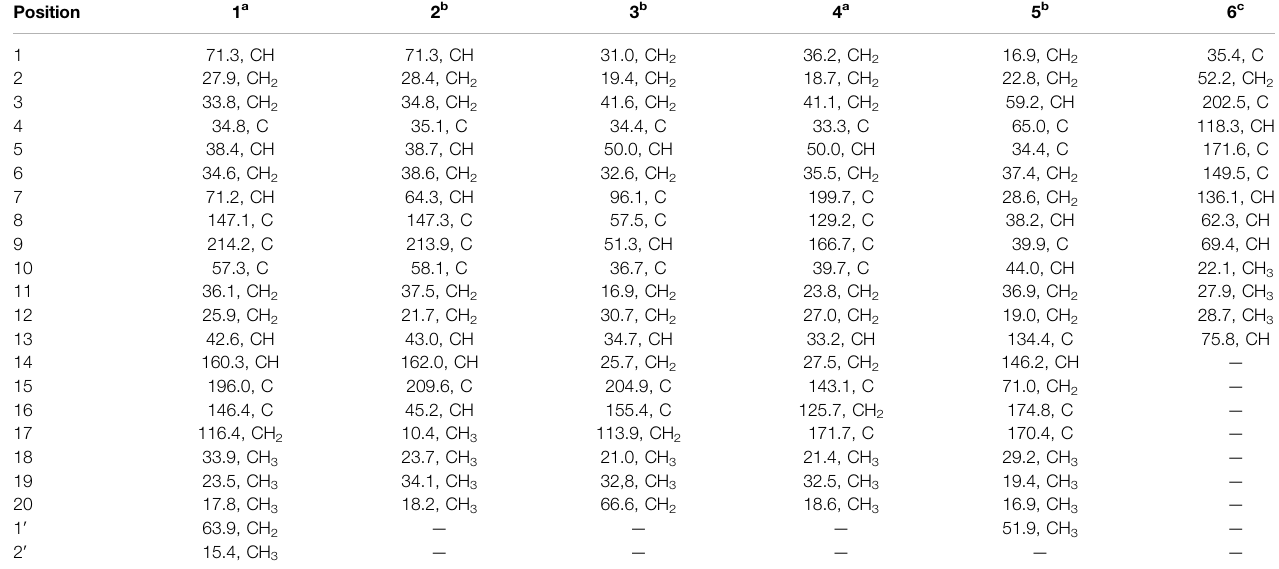
TABLE 2 | 13 C NMR (125 MHz) data of compounds 1 – 6 ( δ in ppm).